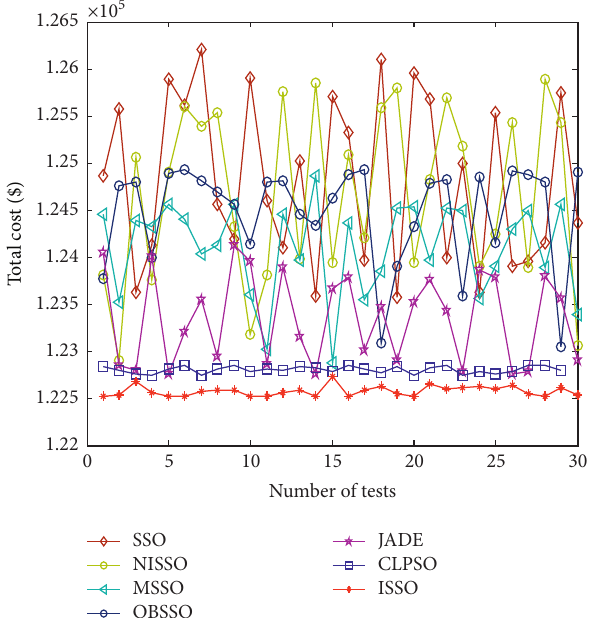
Figure 3: Mean of 30 tests of the 40-unit system.